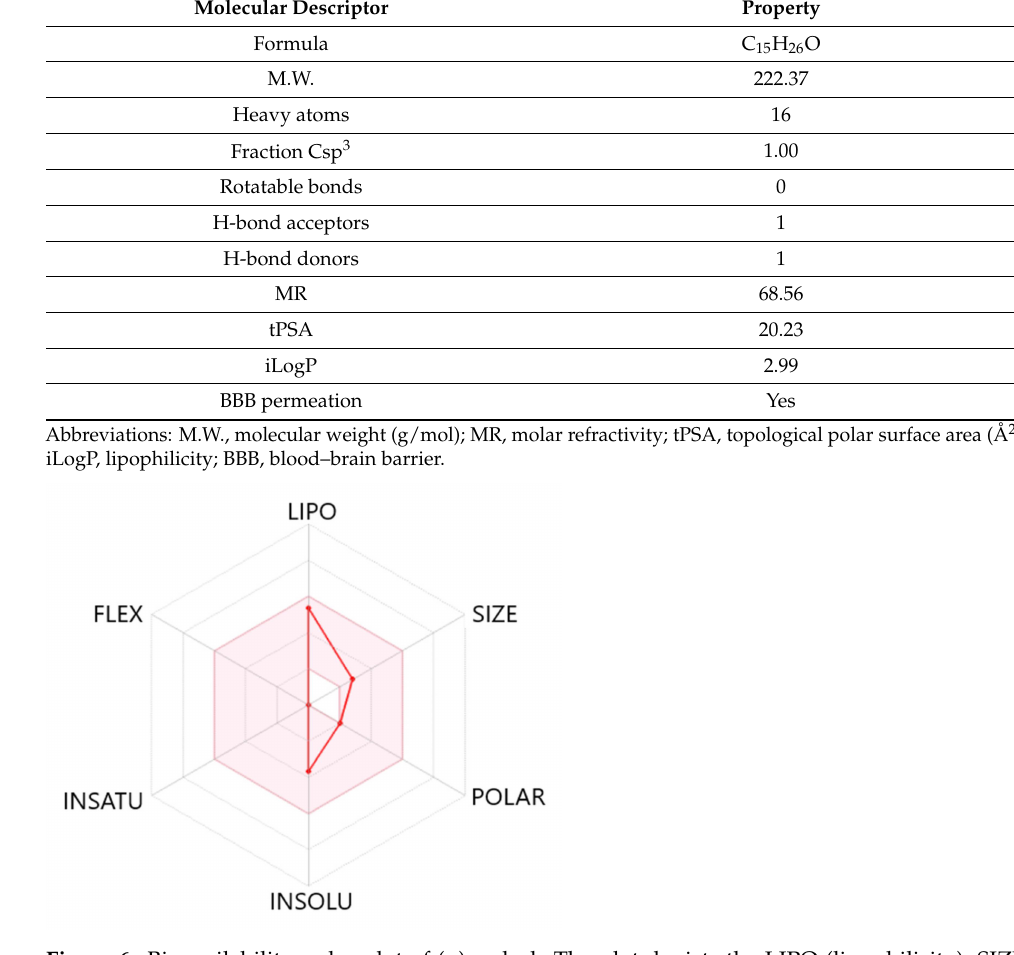
Figure 6. Bioavailability radar plot of (+)-cedrol. The plot depicts the LIPO (lipophilicity), SIZE (molecular weight), POLAR (polarity), INSOLU (insolubility), INSATU (unsaturation), and FLEX (rotatable bond flexibility)